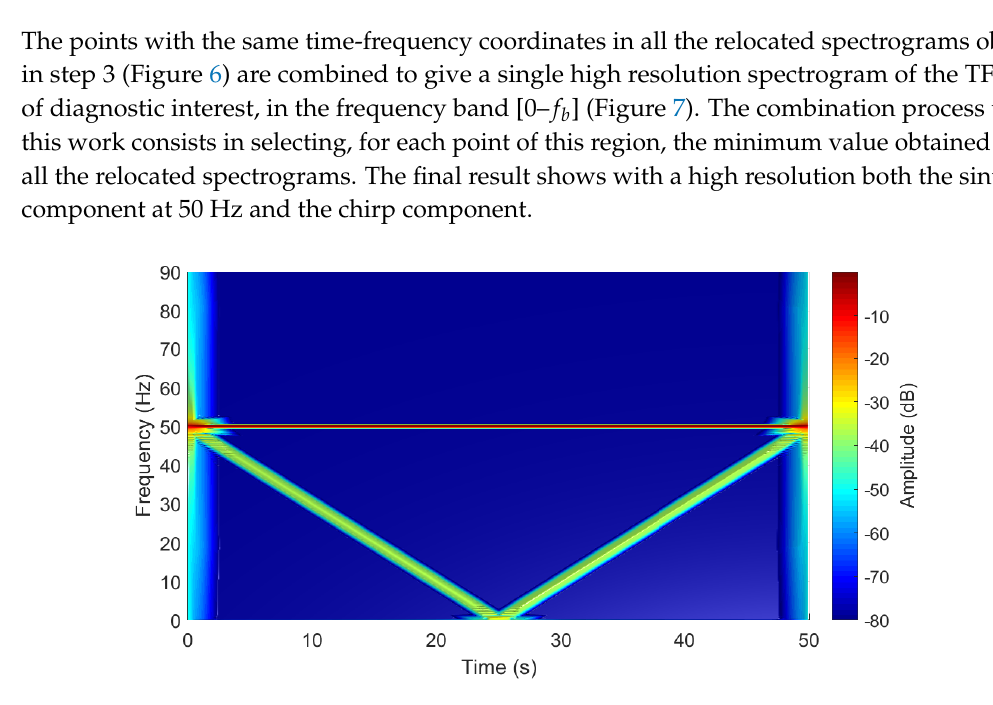
Figure 7. High resolution spectrogram of the current signal (17) —for each point of the time frequency (TF) region of interest, the minimum value obtained among all the stacked spectrograms of Figure 5, right, is selected. The final result shows with a high resolution both the sinusoidal component at 50 Hz and the chirp